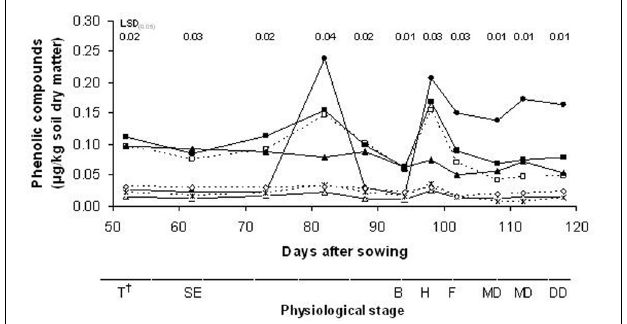
FIGURE 3 | Time-courses of plant height ( • ), leaf/ stem ratio ( (cid:2) ), source/ sink ratio ( (cid:3) ) and shoot/ root ratio ( ◦ ). Data are means of three replicates, vertical lines represent ± standard error. † T, tillering; SE, stem elongation; B, booting; H, heading; F, flowering; MD, milk development; DD, dough development; KH, kernel hard.